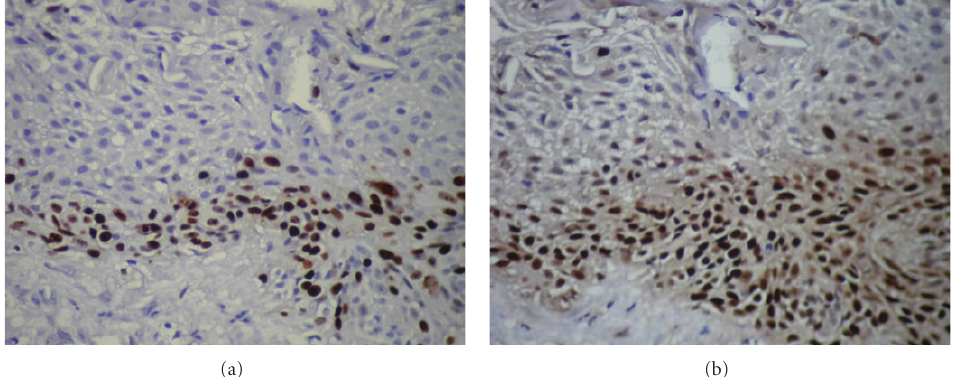
Figure 9: (a) The expressions of Ki-67 in epithelium of keratocystic odontogenic tumors (Ki-67 × 40). (b) The expressions of MCM-2 in epithelium of keratocystic odontogenic tumors (MCM-2 ×